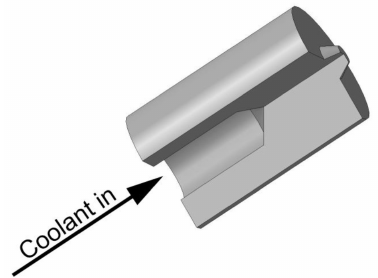
Figure 2. Scheme of working tool from ZhS6U alloy for FSW titanium alloys. The arrow shows the coolant inflow